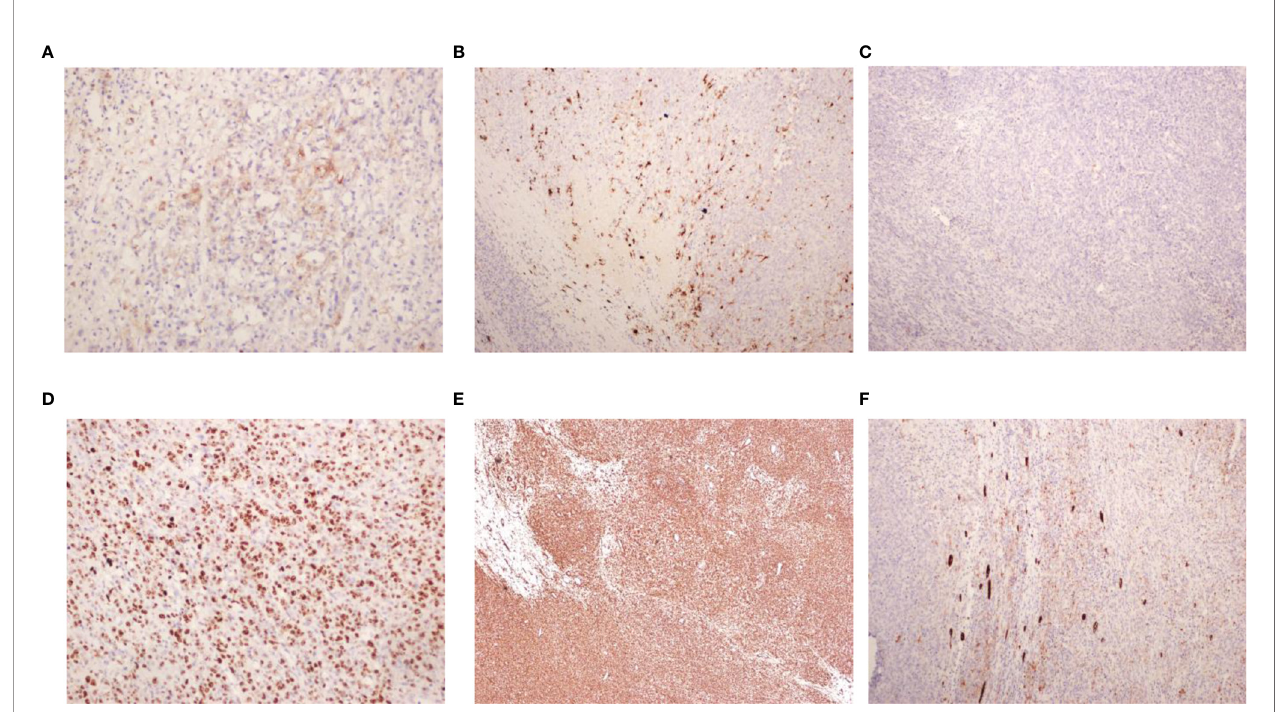
FIGURE 2 | Pathological fi ndings. (A) EMA (x200); (B) S-100 (x100); (C) INI-1 (x100); (D) Ki-67 (x200); (E) Vim (x40); (F) CK